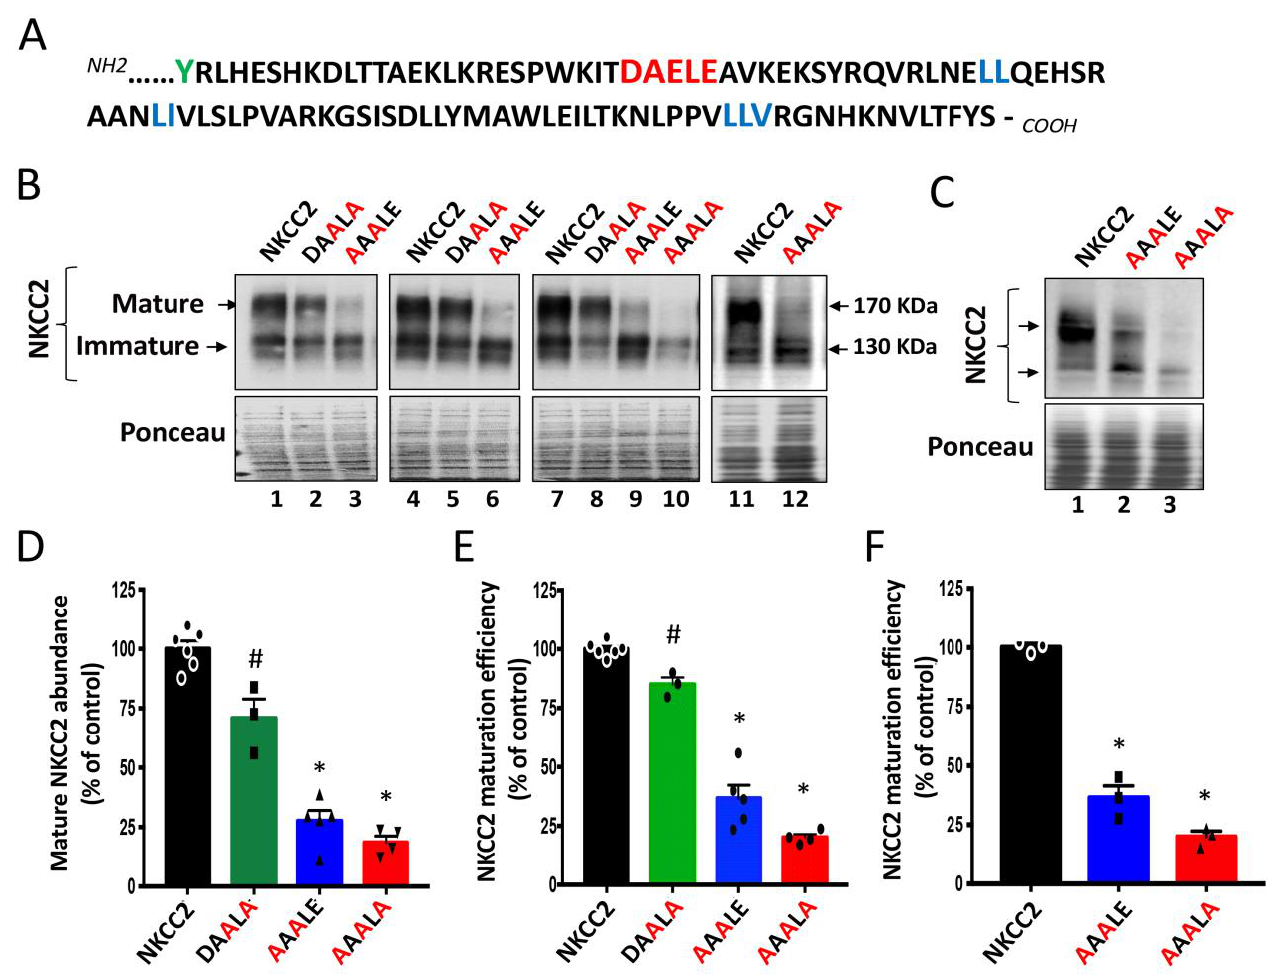
Figure 1. Identification of di-acidic ER export codes in NKCC2 COOH-terminal domain. ( A ) In addition to the previously identified di-leucine motifs (blue), the distal region of NKCC2 COOH terminus contains also a potential ER export signal, the DAELE motif (red), located downstream from Y residue (green), where nonsense mutation Y998X occurs. ( B ) Immunoblot analysis of OKP cells expressing wild-type or mutant NKCC2 proteins as indicated. Cells were transiently transfected with WT NKCC2 or mutated NKCC2 proteins; 1019 AAALE 1023 or 1019 AAALA 1023 . Forty-eight hours post-transfection, total cell lysates were separated by SDS-PAGE and probed by anti-Myc antibodies. The positions of the core (immature) and complex-glycosylated (mature) proteins are indicated. The lower panel is the same membrane stained with Ponceau S to illustrate the equal loading of protein extracts . ( C ) Immunoblot analysis of HEK cells expressing wild-type or mutant NKCC2 proteins, as indicated, using anti-Myc antibodies. ( D , E ) Quantitative analysis of NKCC2 protein abundance in OKP cells. Data were normalized with the loading control (Ponceau staining) from the same lane in each membrane and are expressed as percentage of control (WT NKCC2) ± SE ( D ). The maturation efficiency of NKCC2 was estimated as the ratio of the mature vs. immature form of the cotransporter in OKP cells ( E ). Circles, squares and triangles represent individual data points for each tested condition (WT NKCC2, DAALA, AAALE and AAALA) as indicated. WT NKCC2, n = 6. DAALA, n = 3. AAALE, n = 5. AAALA, n = 4. # p < 0.05; * p < 0.0001 versus WT NKCC2. ( F ) Quantitative analysis of NKCC2 maturation efficiency in HEK cells. Data are expressed as percentage of control ± SE. * p < 0.0001 (n = 3) versus WT